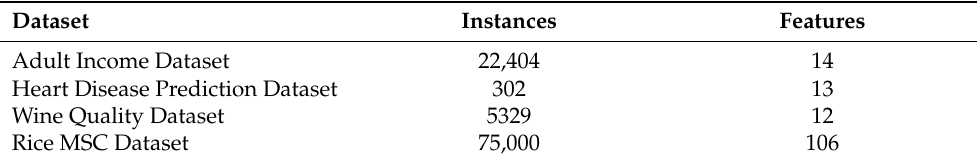
Table 1. Overview of